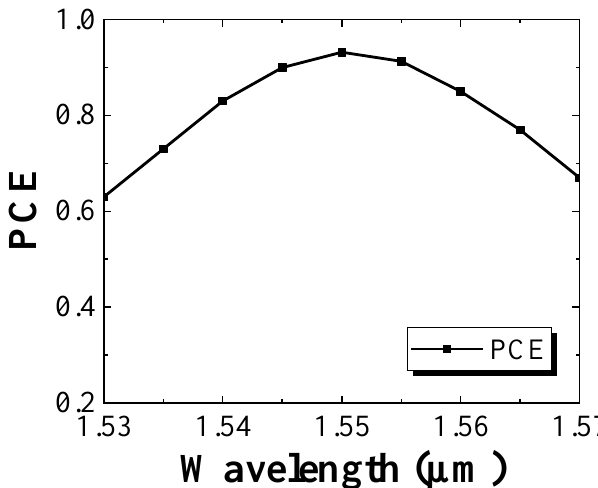
Figure 11. Maximum PCE as a function of the wavelength.